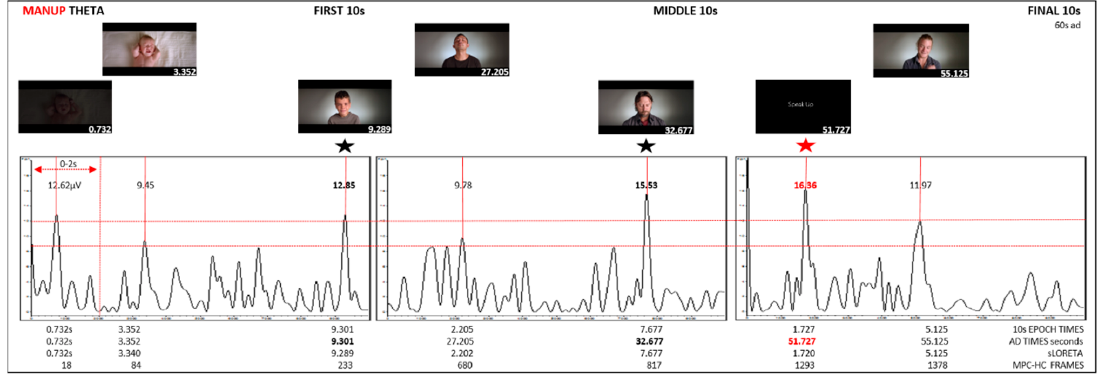
Figure 2. ManUp grand average theta from first, middle, and final 10 second epochs.